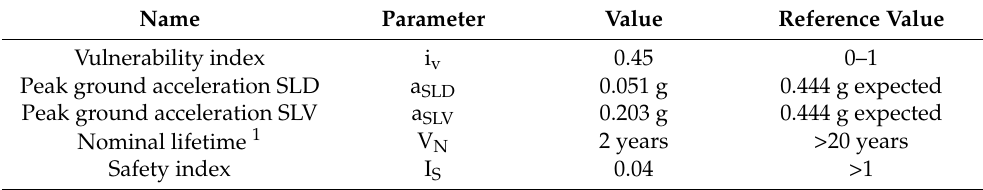
Table 5. Parameters and values calculated according to the directive’s indications.